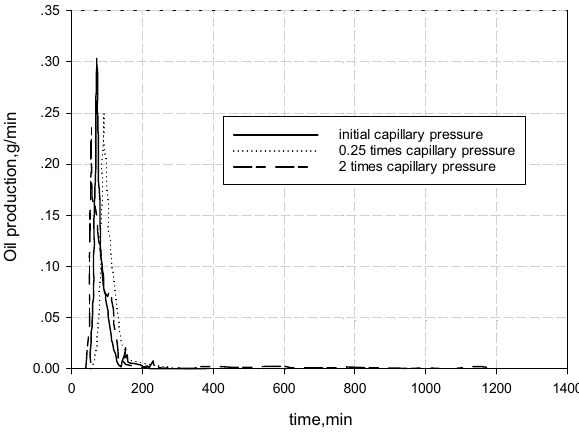
Fig. 8 Oil production rate curve under different capillary pressures